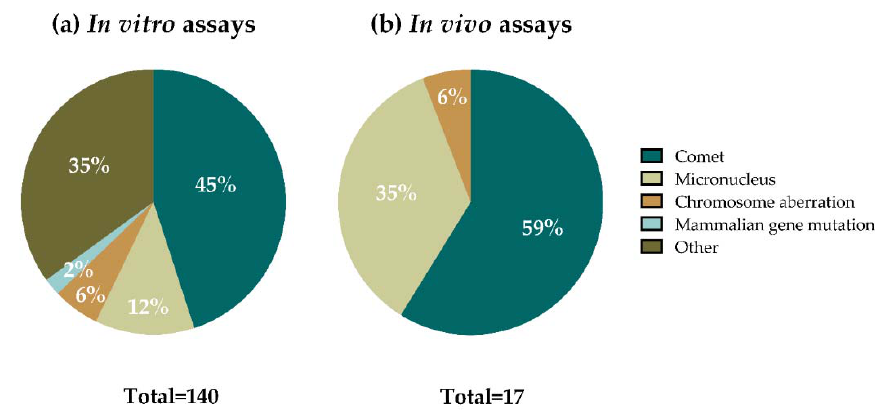
Figure 4. Percentages of the different assays carried out using ( a ) in vitro and ( b ) in vivo approaches among the evaluated publications.